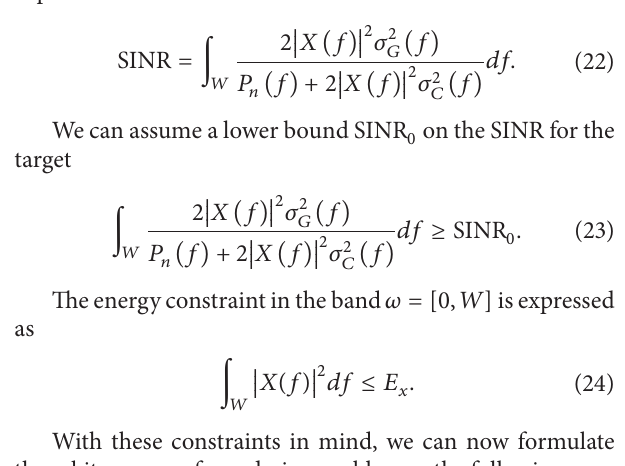
Figure 5 is energy spectrum of unconstrained